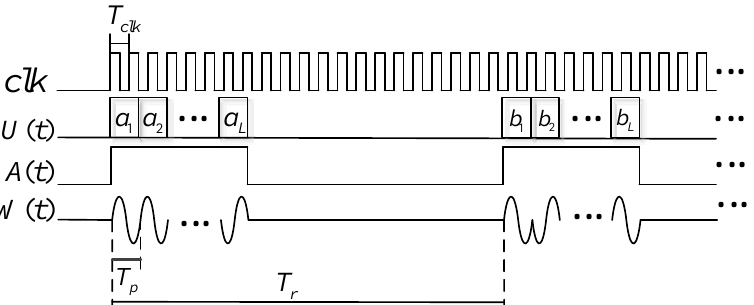
Figure 4. The specific waveform of the radar transmitting signal. Driven by the system clock clk , the transmitting waveform W ( t ) is generated according to the code sequence U ( t ) and transmitting pulse A ( t ) . The positive and complement codes are transmitted alternately.